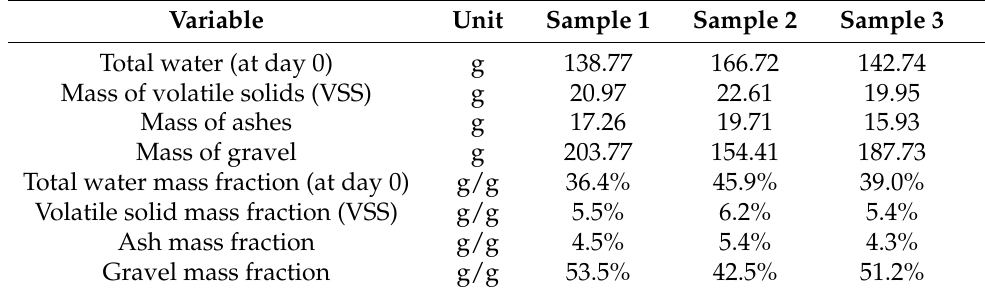
Table 1. Sample composition.